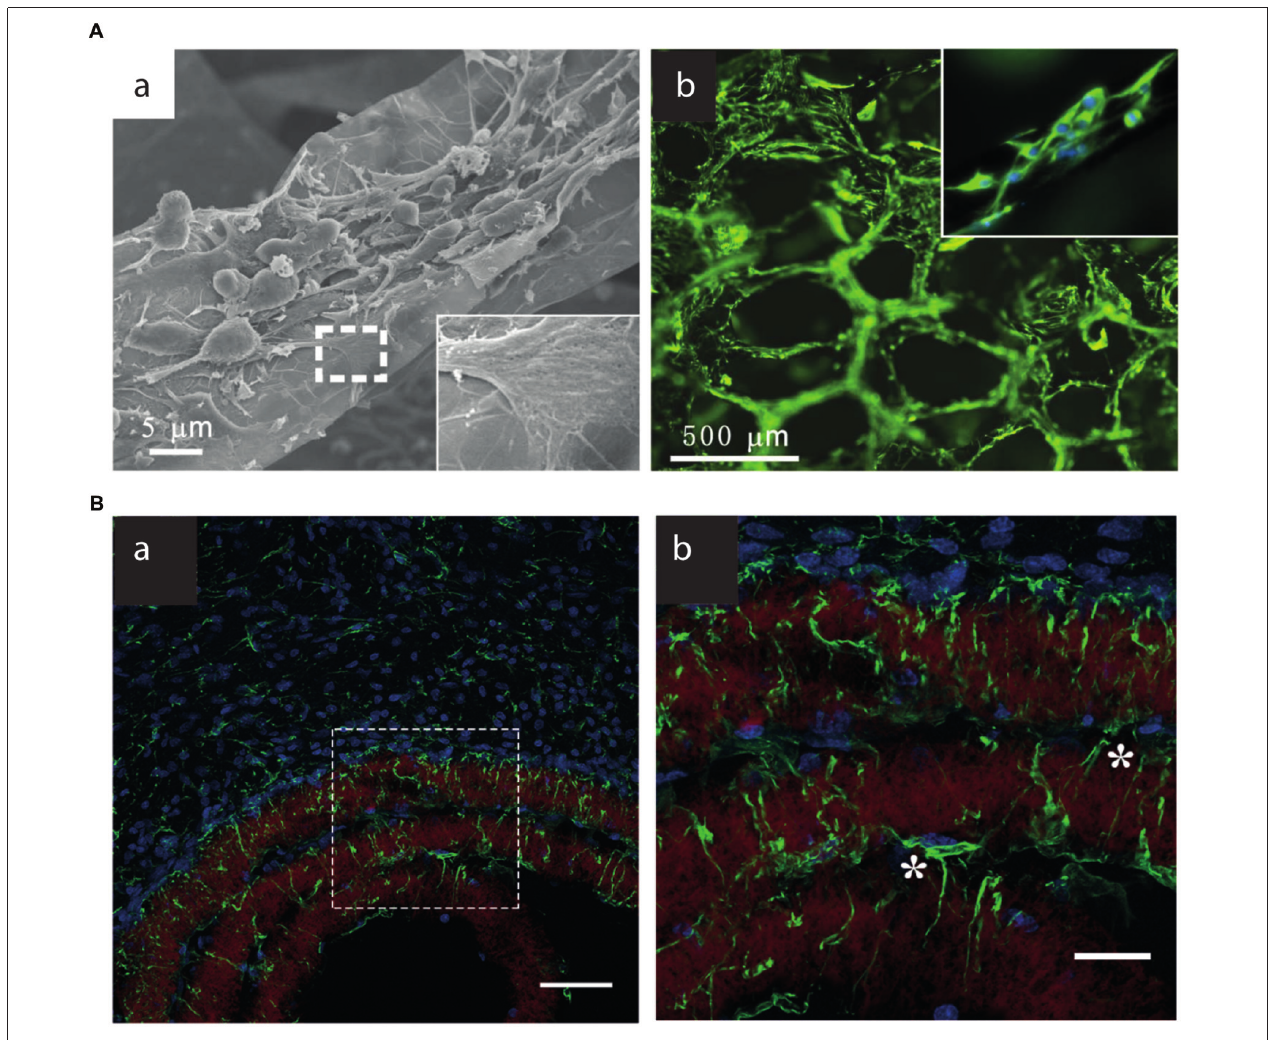
FIGURE 4 | 3D G-Scaffolds in vitro and in vivo . (A) (a) SEM images of neural stem cells (NSCs) cultured on 3D-G foams under proliferation conditions. The insets illustrate the interaction between the cell filopodia and surface. (b) Fluorescence images of NSCs cultured on 3D-G foams for 5 days. Nestin (green) is a marker for NSCs, and DAPI (blue) identifies nuclei. Modified with permission from Li N. et al. (2013). (B) (a,b) Brain astrocyte/G-scaffolds interaction and astrocyte process infiltration 3 weeks after scaffold implantation. Green: GFAP-positive astrocytes, blue: DAPI-stained nucleus, red: surface-functionalized scaffolds. (b) Detailed astrocyte morphology of the dash-box indicated area in (a) . ∗ Indicate astrocytes that bridge a gap between two scaffold layers. Scale bar, 50 (a) and 20 (b) µ m. Modified with permission from Zhou et al.